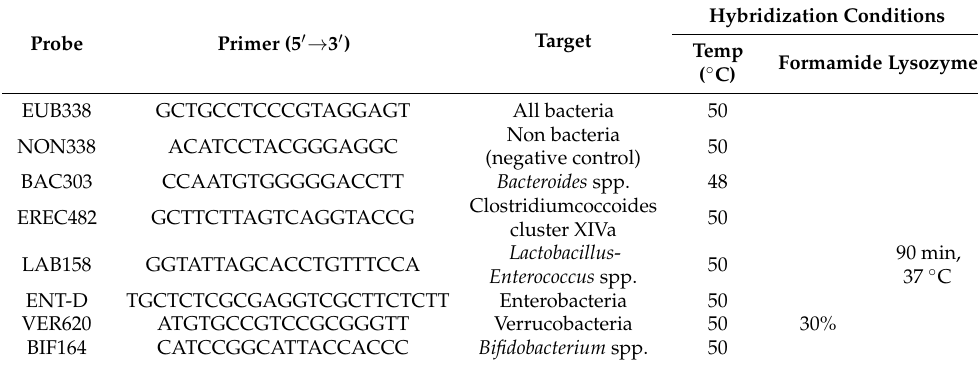
Table 3. Probes used for FISH and hybridization